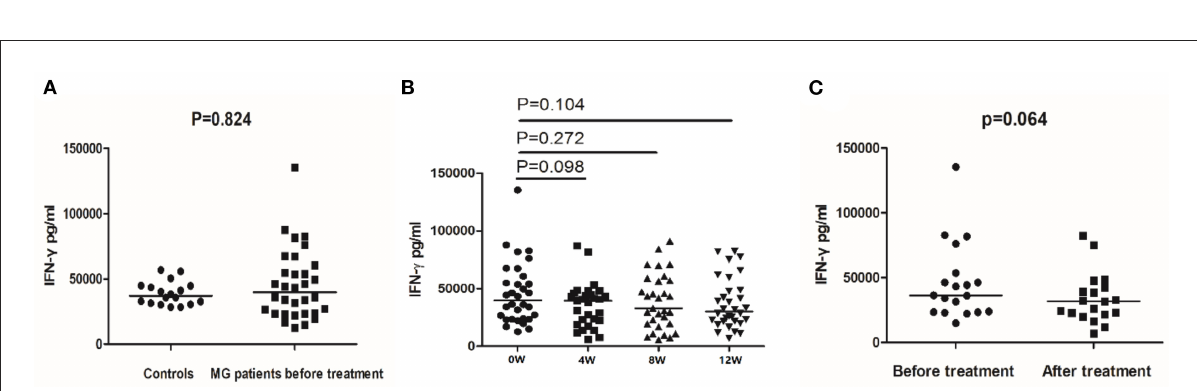
FIGURE2 IFN- γ secretion detected by ELISA in controls and MG patients. (A) IFN- γ secretion in PBMCs of healthy controls and MG patients before treatment. (B) IFN- γ secretion in PBMCs of MG patients before treatment and after 4, 8, and 12 weeks of treatment. (C) IFN- γ secretion in PBMCs of responsive MG patients before treatment and at 12 weeks. The horizontal bars indicate the median. The amount of IFN- γ secretion was a continuous variable with a non-normal distribution. We compare MG patients and controls using Welch’s corrected unpaired rank sum test. We compared before and after treatment using a paired rank sum